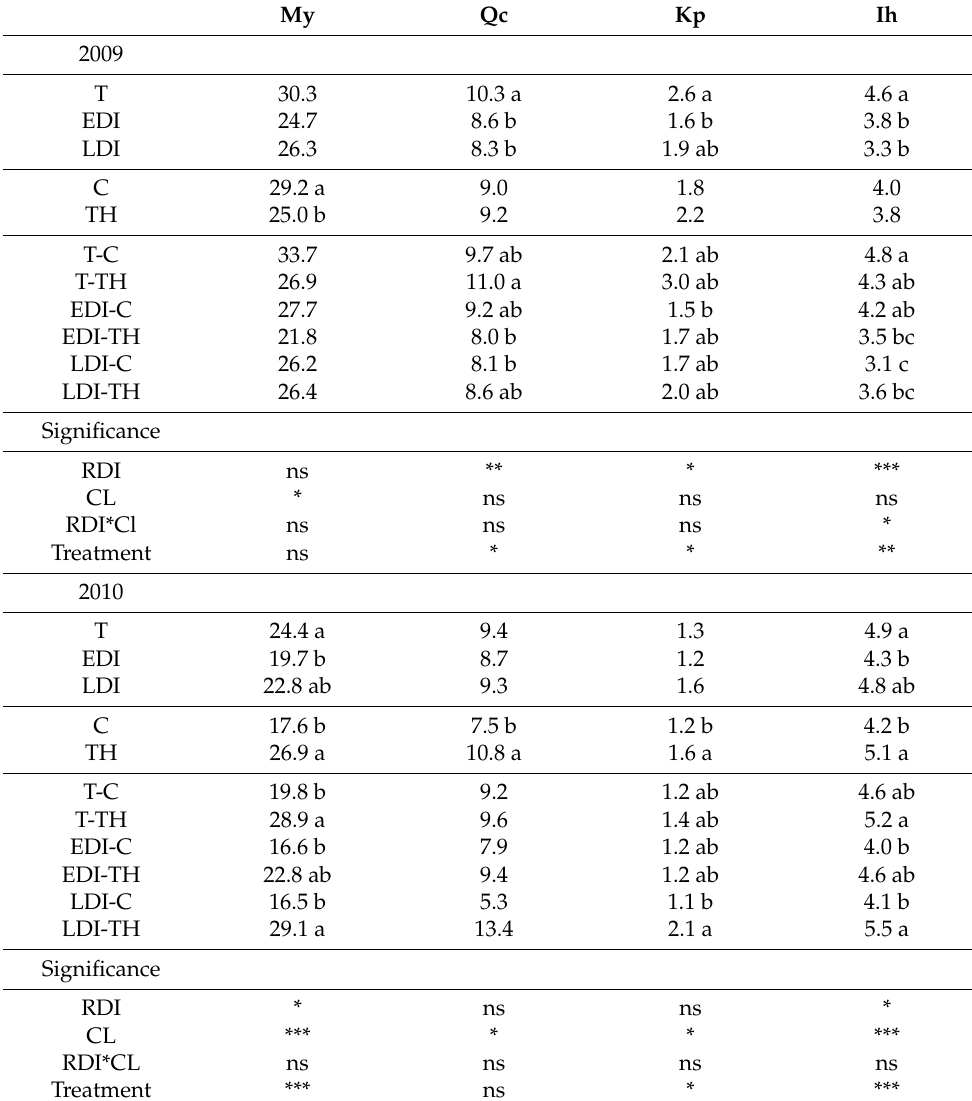
Table 2. Effects of regulated deficit irrigation and cluster thinning on grape skin flavonol concentration (mg/kg berry fresh weight) in 2009 and